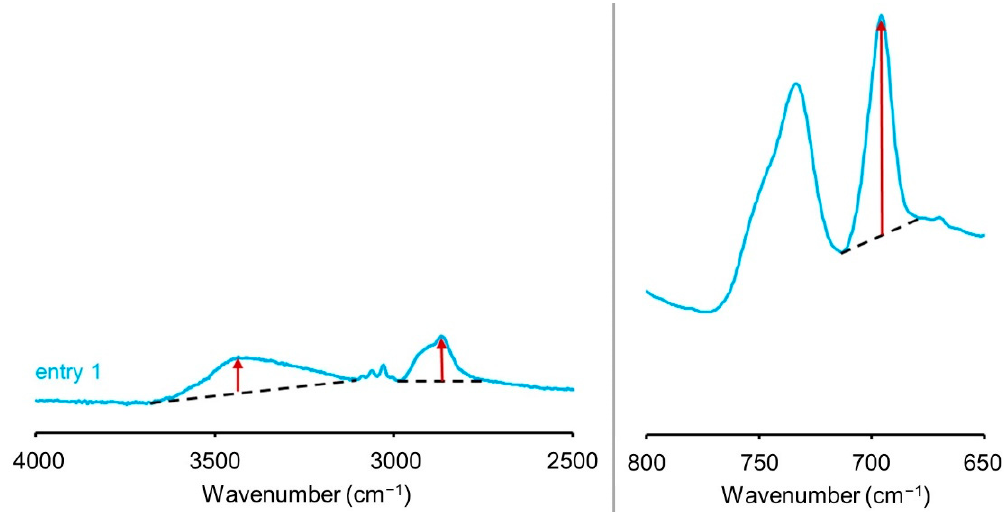
Figure 2. Intensities of peaks at approximately 3400, 2870, and 696 cm − 1 in the IR spectra of benzylated wood (entry 1).